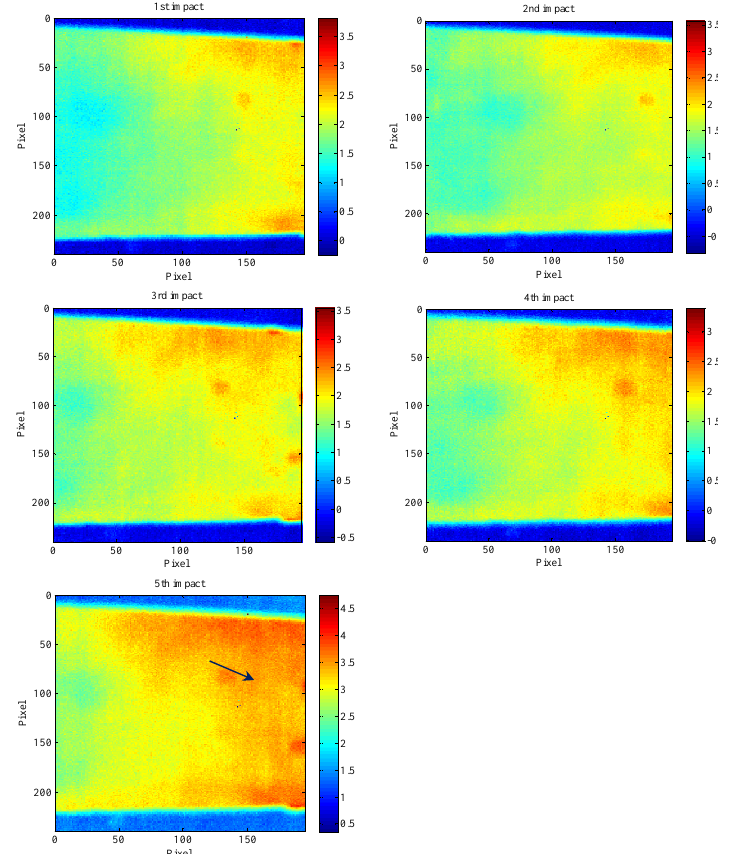
Figure 3. Thermal contrast of first five impacts in the warm ‐ up period (The arrow indicates the high temperature abnormal zone).